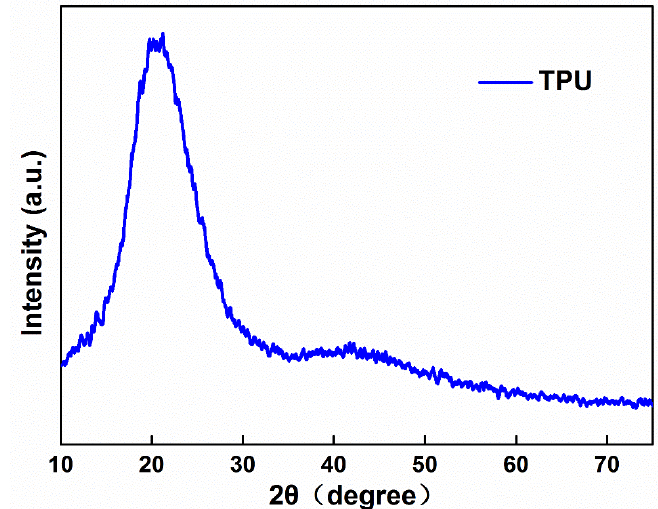
Figure 6. XRD Patterns of TPU fibers.